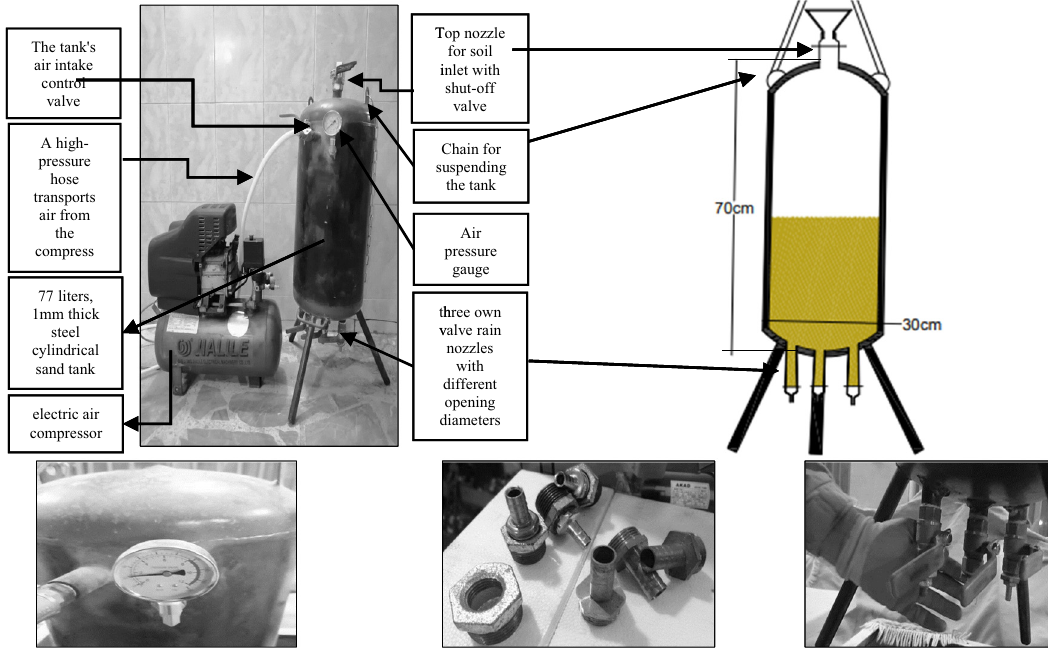
Figure 2: TARD details.